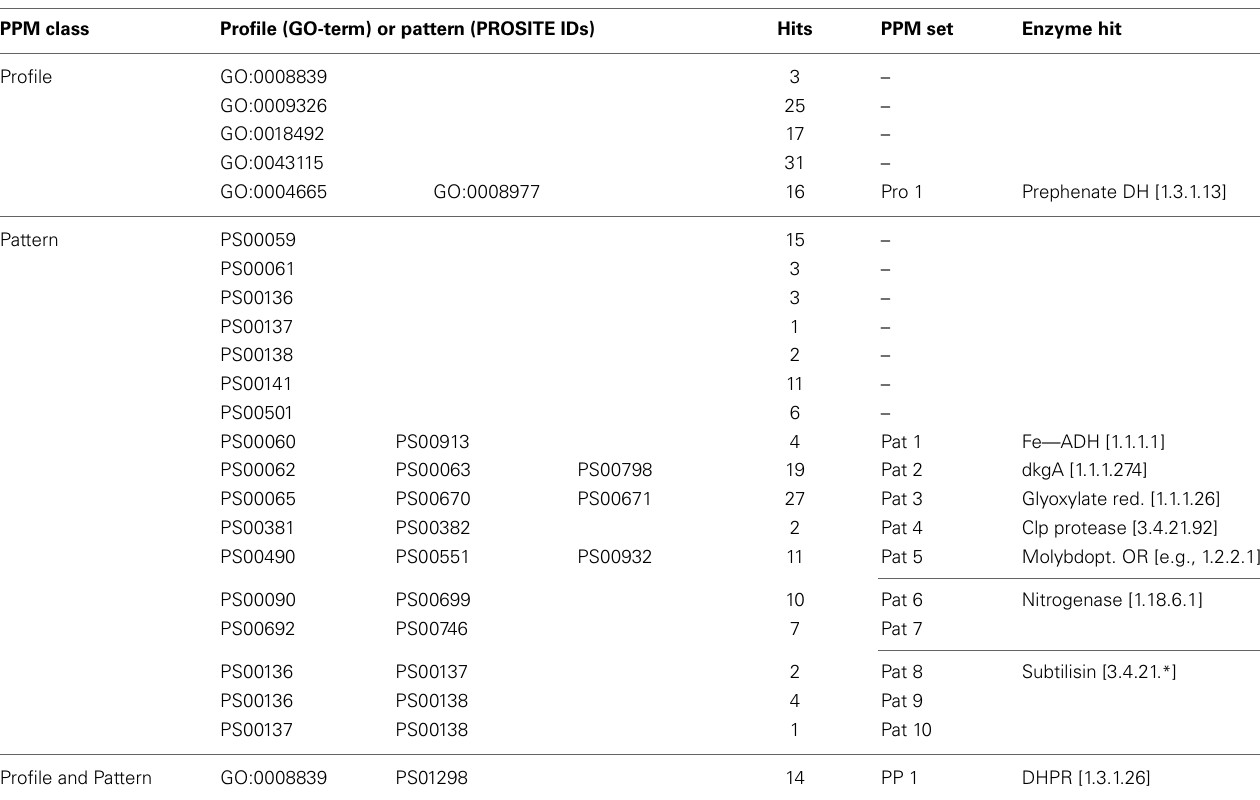
Table 5 | Enzyme hits identified using the PPM algorithm and the respective PPM